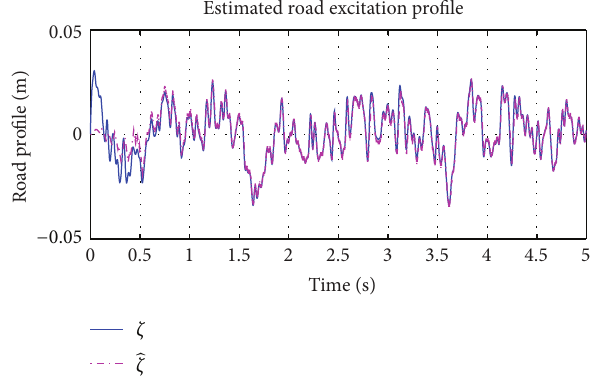
Figure 6: Estimation of road profile, 𝜁(𝑡)